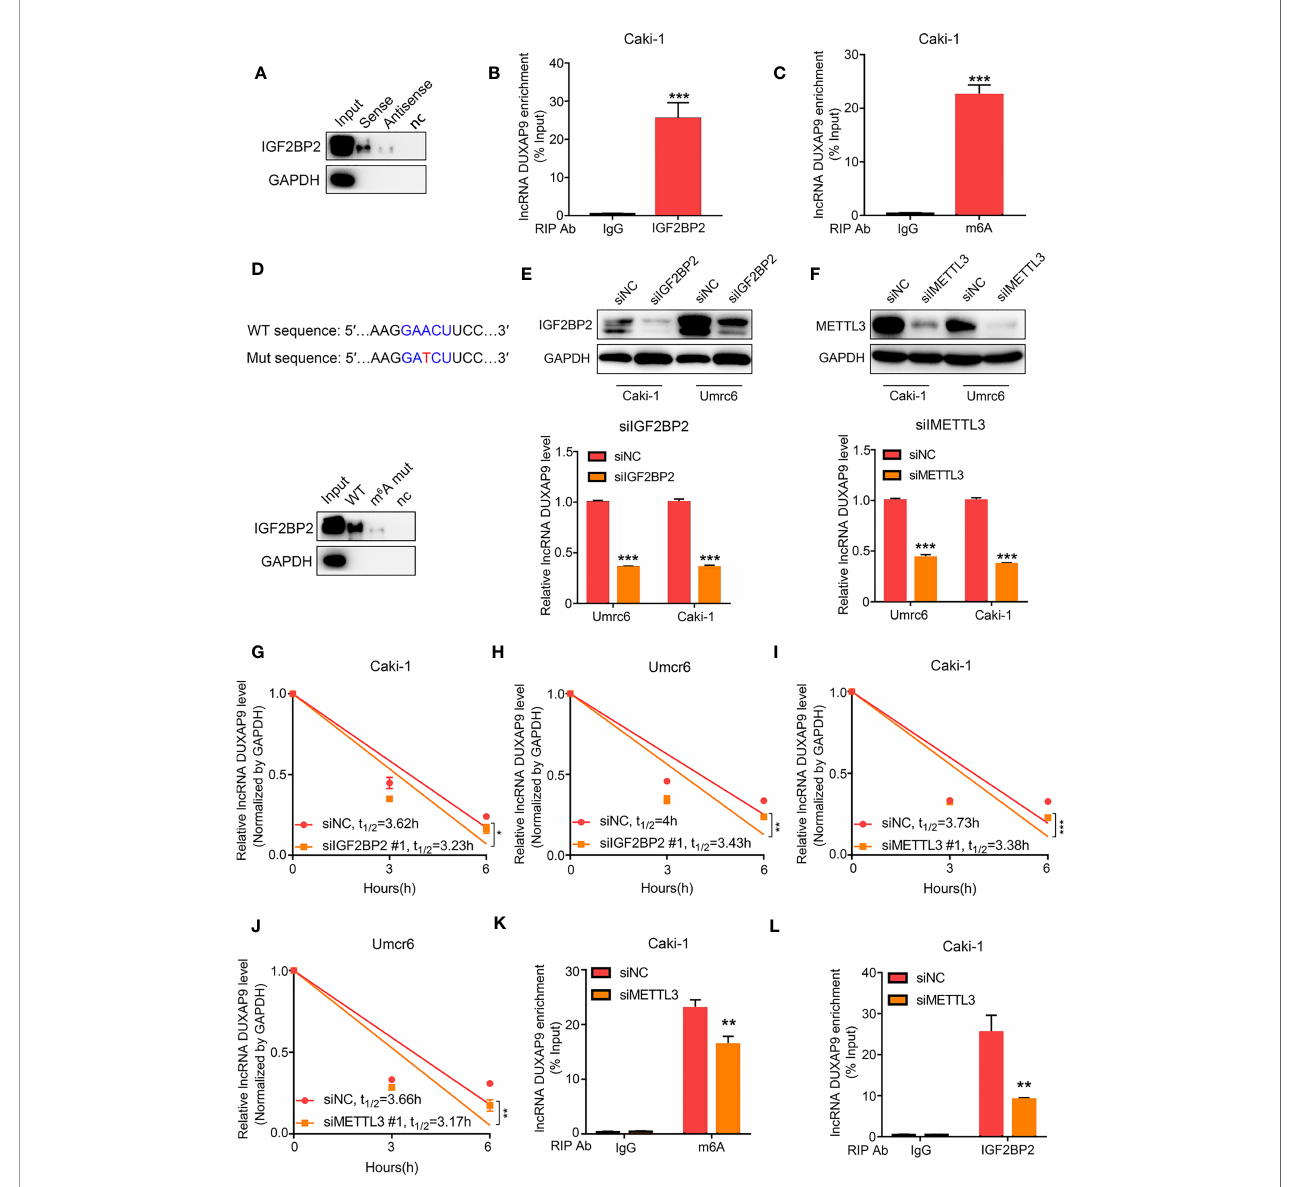
FIGURE 5 | DUXAP9 interacts with IGF2BP2 through GAACU motif (an m6A motif). (A) Immunoblotting of IGF2BP2 after RNA pull down assay showing its speci fi c related with DUXAP9 in Caki-1 cells. (B) RIP-qPCR assays demonstrated IGF2BP2 binds to DUXAP9. Relative enrichment representing LncRNA levels associated with IGF2BP2 compared to IgG antibody served as a control. (C) MeRIP assays in Caki-1 cells con fi rming that DUXAP9 exhibits m6A modi fi cation. (D) Top, Schematic diagram of the m6A motif (GAACU) in DUXAP9 and the mutation used in the subsequent RNA pull-down assay. Down: Immunoblotting of IGF2BP2 after RNA pull down assay showed that the binding of IGF2BP2 to DUXAP9 was decreased by the DUXAP9 mutation of the m6A-binding motif. (E – J) Inhibition of IGF2BP2 and METTL3 decreased the DUXAP9 level (E, F) and the DUXAP9 half-life in Umrc6 (H, J) and Caki-1 (G, I) treated with actinomycin D to inhibit further transcription. (K) MeRIP-qPCR assays (using m6A-speci fi c antibody vs. control) after METTL3 silencing showed that DUXAP9 enrichment was decreased. (L) RIP-qPCR assays (using IGF2BP2-speci fi c antibody vs. control) after METTL3 silencing showed that DUXAP9 enrichment was decreased. Data represent mean ± SD from three independent experiments. RIP, RNA immunoprecipitation; qPCR, quantitative polymerase chain reaction; MeRIP, methylated RNA immunoprecipitation; *P < 0.05; **P < 0.01; ***P <